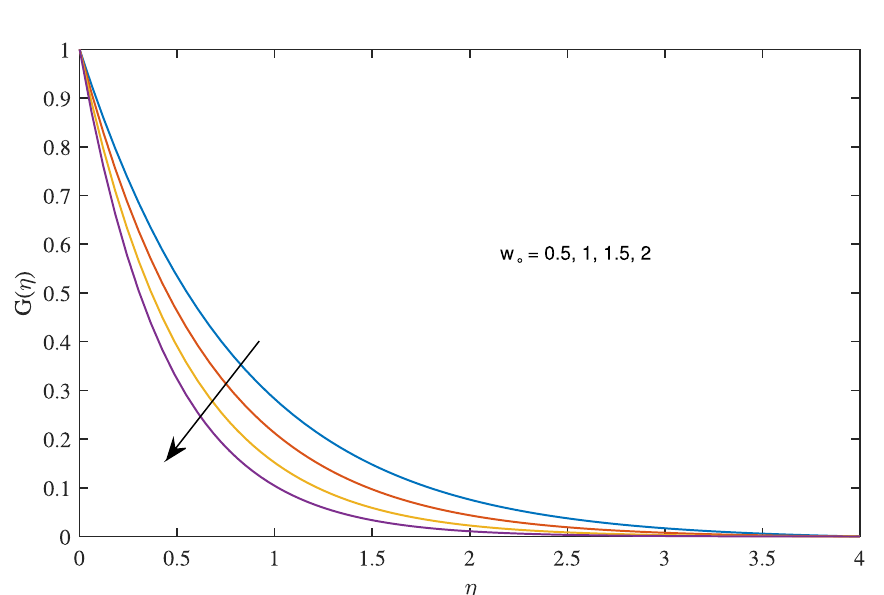
Figure 7. Effects of variation of suction parameter w 0.1 and Pr 0.2 , φ N rd = =